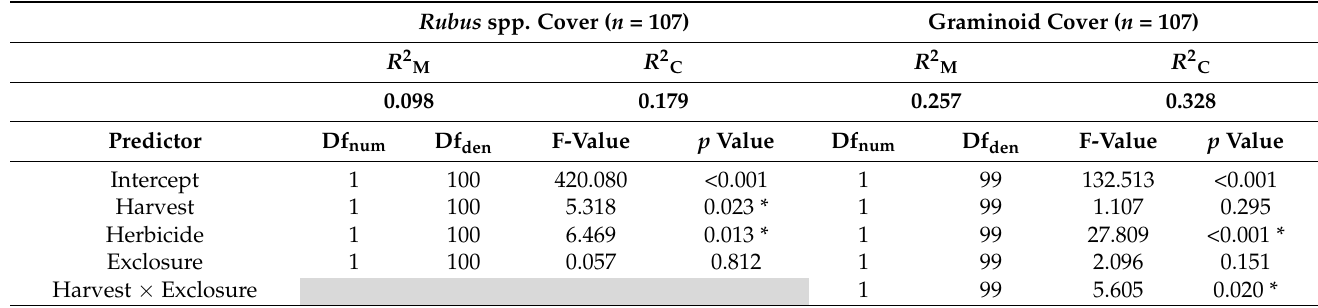
Table 5. Mixed model effects of harvest, herbicide, and exclosure on post-treatment Rubus spp. and graminoid cover in managed northern hardwood forests in the Upper Peninsula of Michigan, USA. Cover among three 1 m 2 subplots was averaged prior to analysis. The site was included as a random effect. Models first included all treatment interactions and were then simplified if no interaction effect was detected. * Asterisks indicate statistical significance ( p < 0.05). R 2 M , marginal R 2 (fixed effects only); R 2 C , conditional R 2 (fixed and random effects); Df num , numerator degrees of freedom; Df den , denominator degrees of